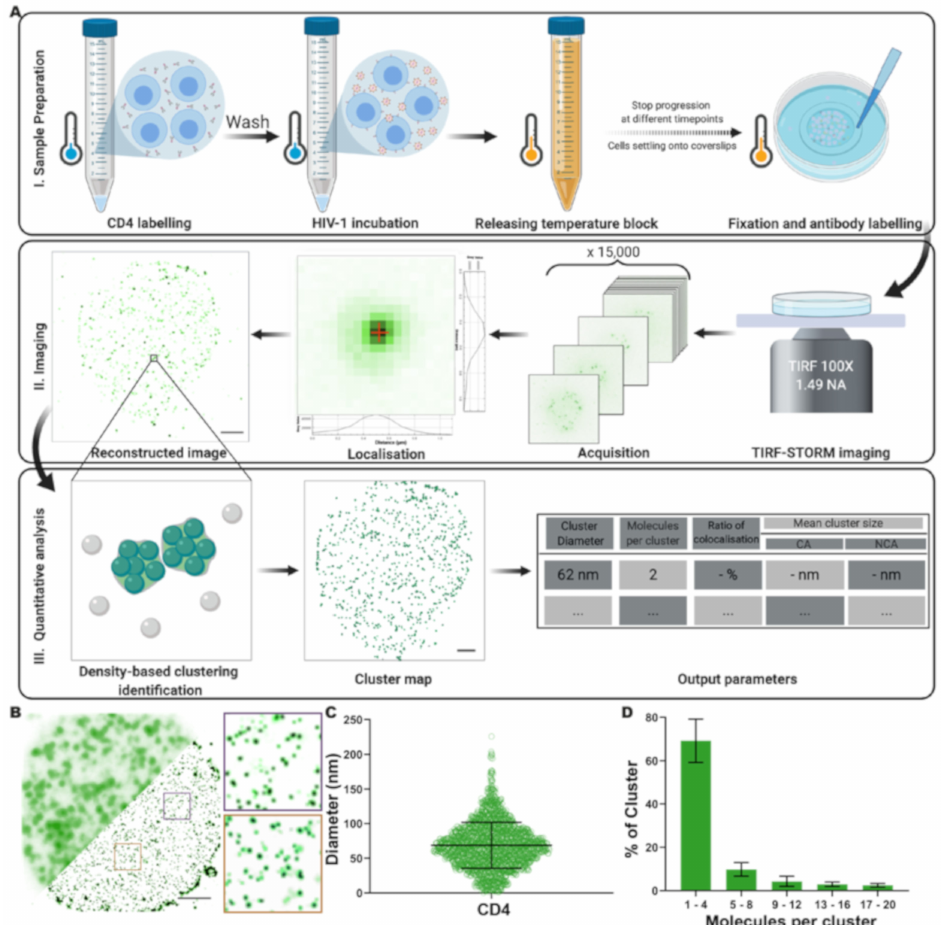
Figure 1. Experimental and analytical pipeline for the quantitative analysis of plasma membrane CD4. ( A ) Schematics of the experimental and analytical pipelines used. (I) SupT1-R5 cells were pre-incubated at 4 ◦ C with OKT4 with or without HIV or gp120, prior to a brief release of the temperature block and rapid cooling prior to fixation. (II) Cells deposited on imaging surfaces were imaged using a standard TIRF-STORM acquisition, and (III) localisations were used for density-based cluster analysis and molecular counting. ( B ) Representative diffraction-limited TIRF (top half) and TIRF-STORM (bottom half) images of CD4 in an untreated SupT1-R5 cell. Insets show enlarged TIRF-STORM images of the indicated regions. Scale bar = 2 µ m. ( C ) Quantification of CD4 cluster diameters in the same cells. Each point represents 1 cluster; 15 cells were measured, giving a total of 11768 clusters. Bars represent mean ± SD. ( D ) Molecular counting of CD4 clusters. Each bar represents the percentage of clusters displaying the indicated ranges of molecules per cluster. Bars represent mean ± SD. All data represent at least three independent